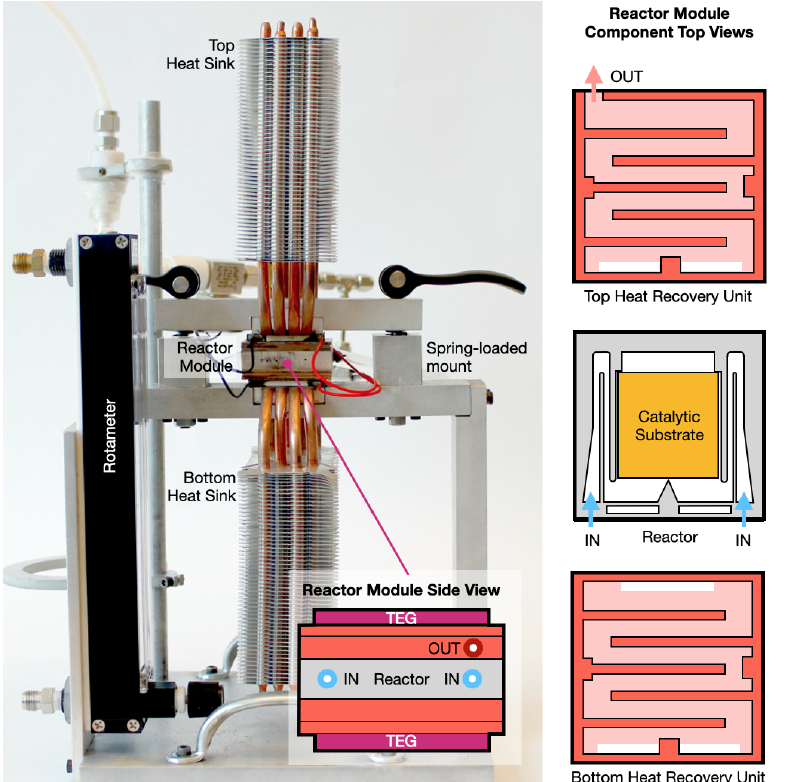
Figure 2. The modified facility is 15 inches in height with a 8 in x 8 in baseplate. The facility includes: a rotameter, bubbler, two heat exchangers, and a reactor assembly that integrates spring-loaded clamps to uniformly distribute pressure across the reactor. Within the layered reactor shown as an inset, the methanol-air mixture enters through the two inlet ports (depicted with blue arrows), travels through the catalytic substrate (illustrated in orange) where combustion occurs, down and across the Bottom Heat Recovery Unit, routed up through two slots in the reactor wall and across the Top Heat Recovery Unit to an outlet port (depicted with an orange